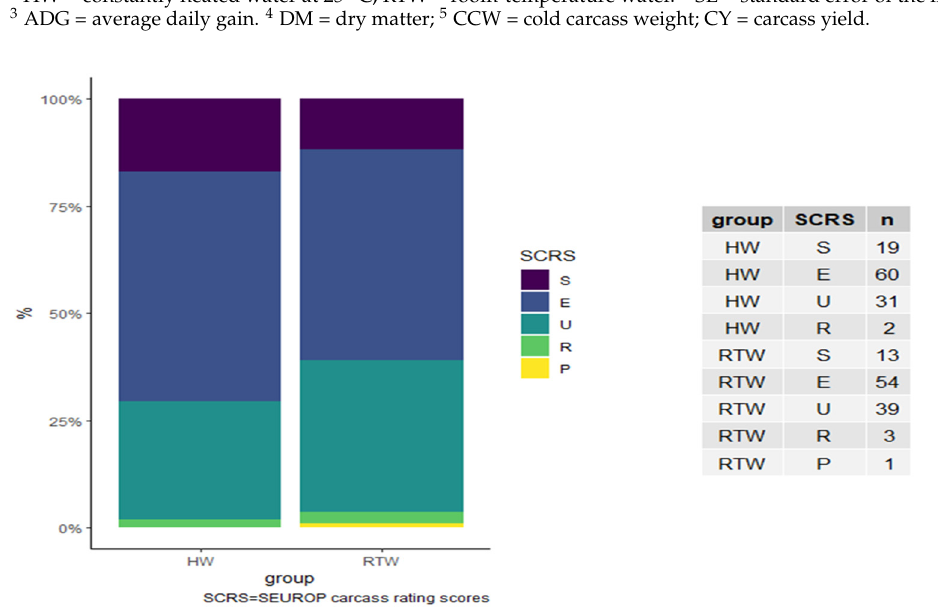
Figure 1. Frequencies of SEUROP carcass rating scores (SCRS) in the two experimental groups. The initial live weight was not significantly different between the two groups (405 ± 38 kg and 408 ± 38 kg for HW and RW, respectively; p = 0.59), suggesting correct allocation on arrival. Additionally, the administration of heated water did not affect the average weights significantly at d 90 (546 ± 40 kg and 544 ± 34 for HW and RW, respectively; p = 0.74) or at the end of the fattening period, d 180 (719 ± 59 kg and 711 ± 57 kg for HW and RW, respectively; p = 0.28) (Table